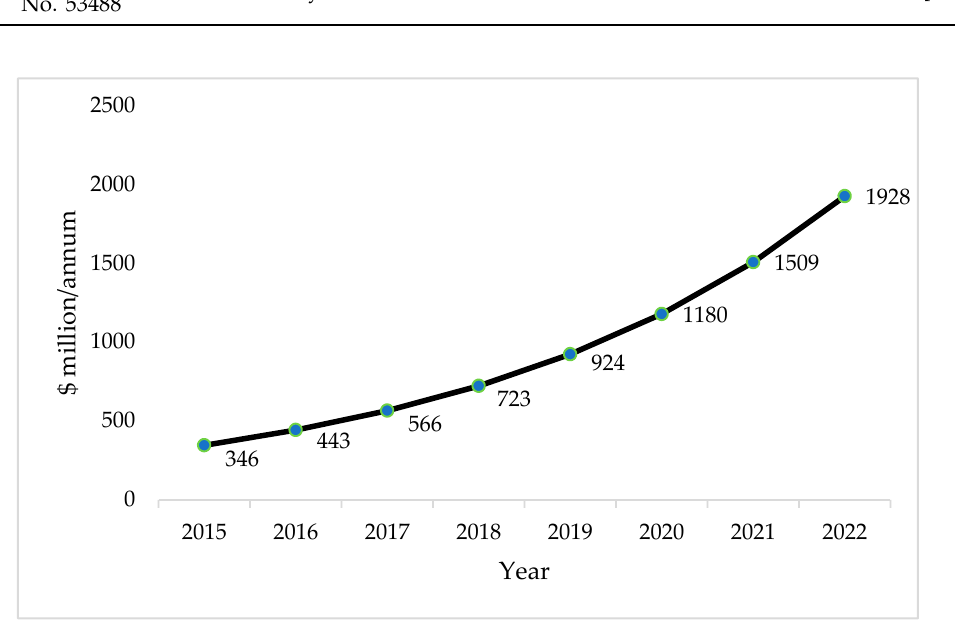
Figure 9. Market forecast of bio-SA volume from the year 2015 to 2022 [112].